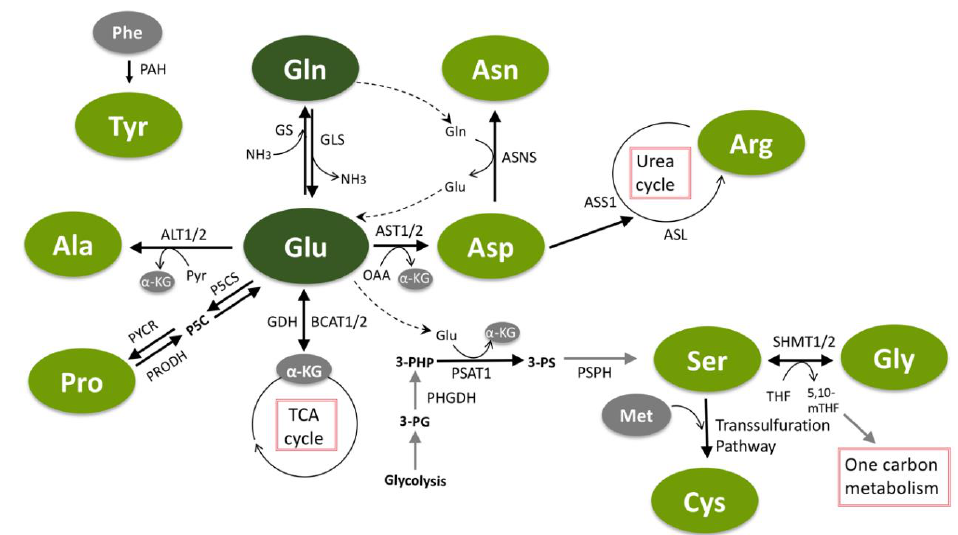
Figure 1. The interconnected pathways of non-essential amino acids (NEAA) metabolism. Glutamine and glutamate have a central role in non-essential amino acid metabolism, and can each be used for the synthesis of other NEAAs. Glutamate can be utilized to generate alanine, aspartate, serine and proline. Aspartate is further utilized to generate asparagine (with nitrogen from glutamine) and can be used in the urea cycle to make arginine. Serine donates methyl groups for one-carbon metabolism and makes glycine in the process. Serine can also be used in the transsulfuration pathway to generate cysteine. Tyrosine is the only NEAA not directly connected to the others, as it is separately synthesized from phenylalanine. Green circles indicate non-essential amino acids. Abbreviations: Gln = glutamine; Glu = glutamate; Phe = phenylalanine; Tyr = tyrosine; Ala = alanine; Pro = proline; Asp = aspartate; Asn = asparagine; Arg = arginine; Ser = serine; Gly = glycine; Met = methionine; Cys = cysteine; α -KG = α - ketoglutarate; ALT1/2 = alanine aminotransferase 1/2; AST1/2 = aspartate aminotransferase 1/2; ASNS =